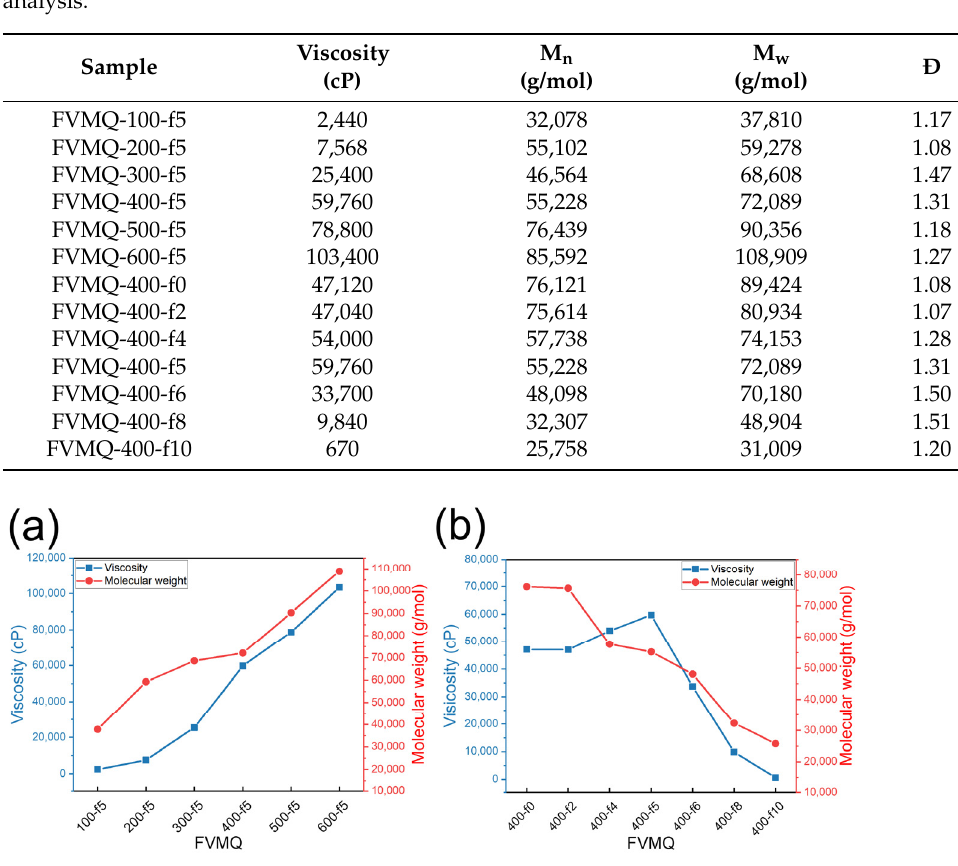
Table 2. Viscosities and molecular weights of FVMQs obtained through the viscometer and GPC analysis.